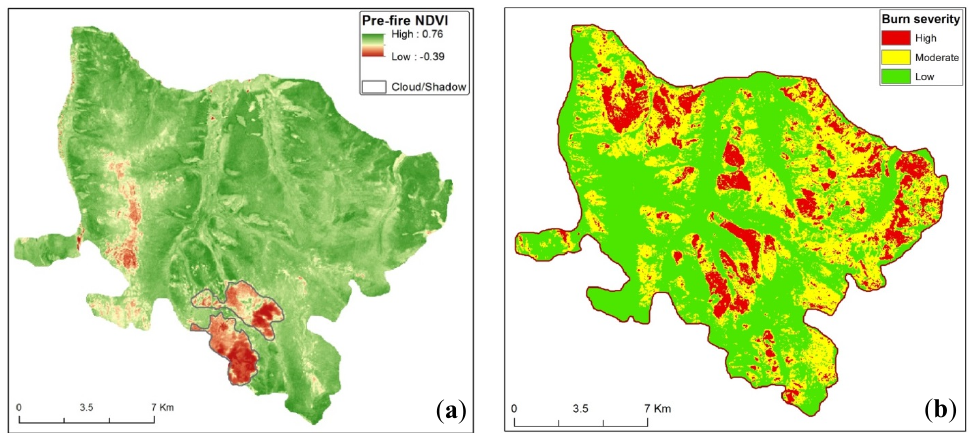
Figure 5. Pre ‐ fire forest condition defined by the NDVI ( a ) and post ‐ fire forest effects defined by burn severity ( b ). The burn severity classes were coded using categorical values of 1 for low, 2 for moderate, and 3 for high burn severity (Adapted from [29]).